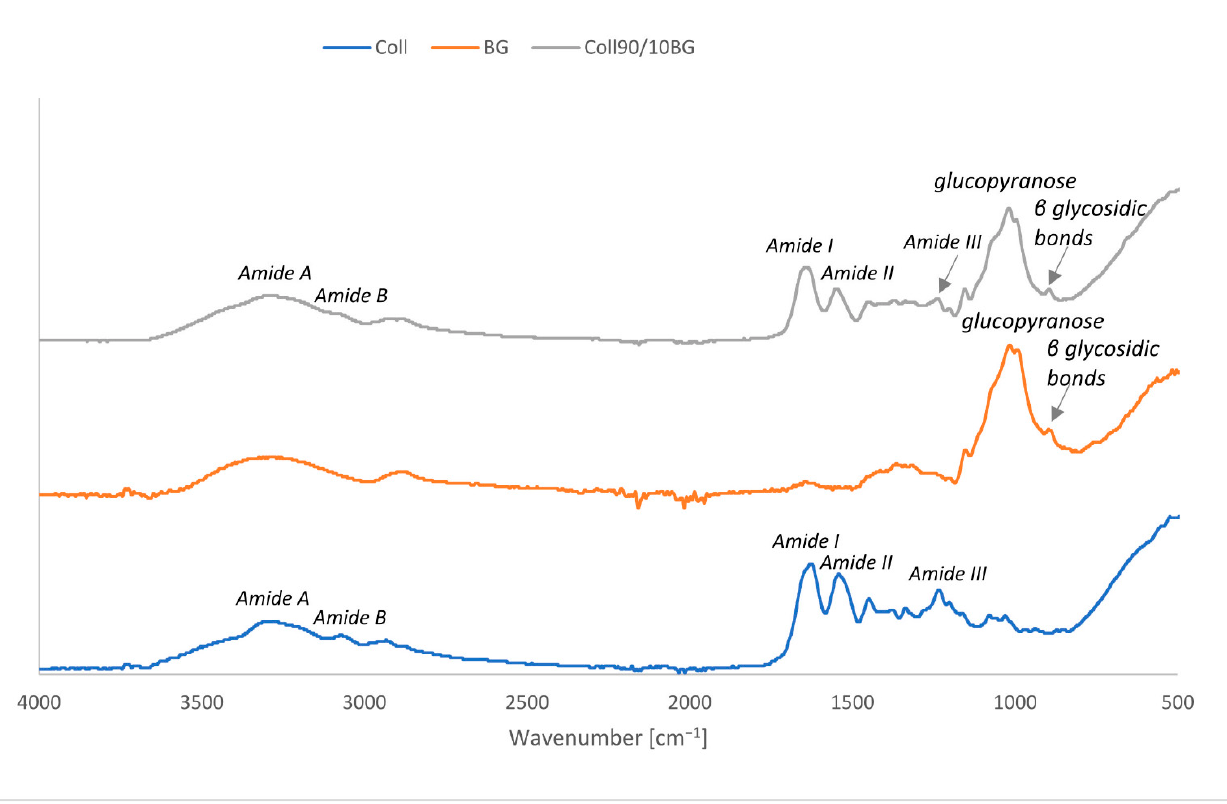
Figure 1. ATR-FTIR spectra collected for collagen, β -glucan, and collagen/ β -glucan material.